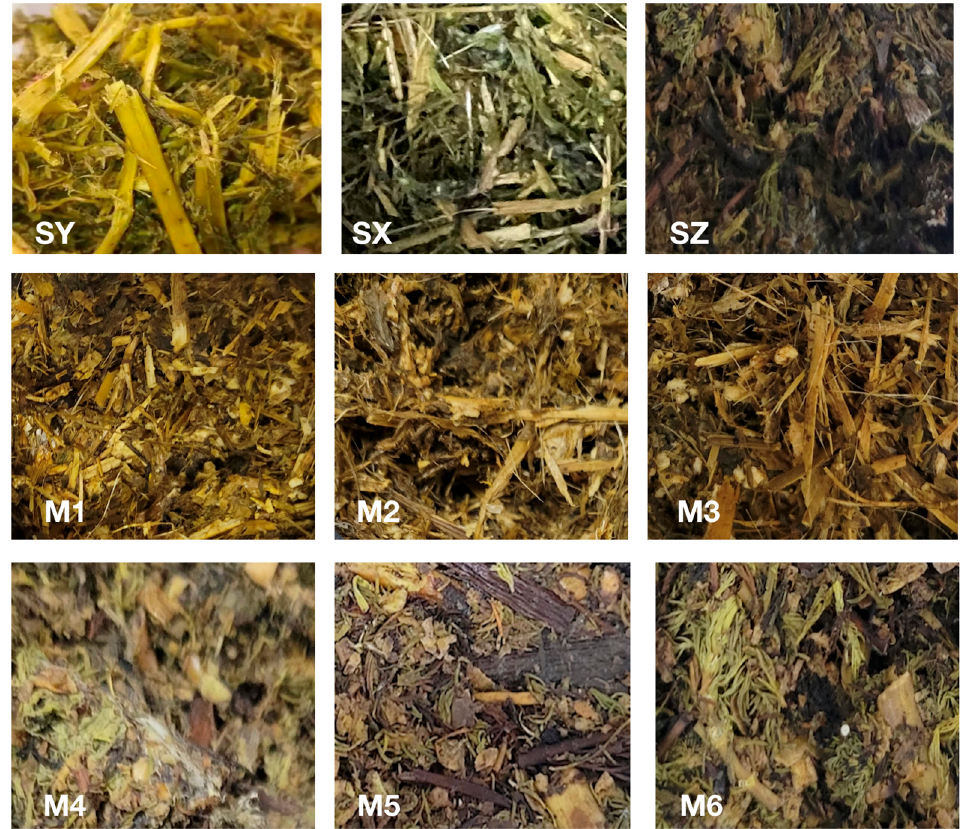
Figure 1. The sensory changes of mixed silage after the cans were opened. Note: SY-Rapeseed silage; SX-Alfalfa silage; SZ- M. spicatum silage; M1-Rapeseed × Alfalfa (3:7); M2-Rapeseed × Alfalfa (5:5);